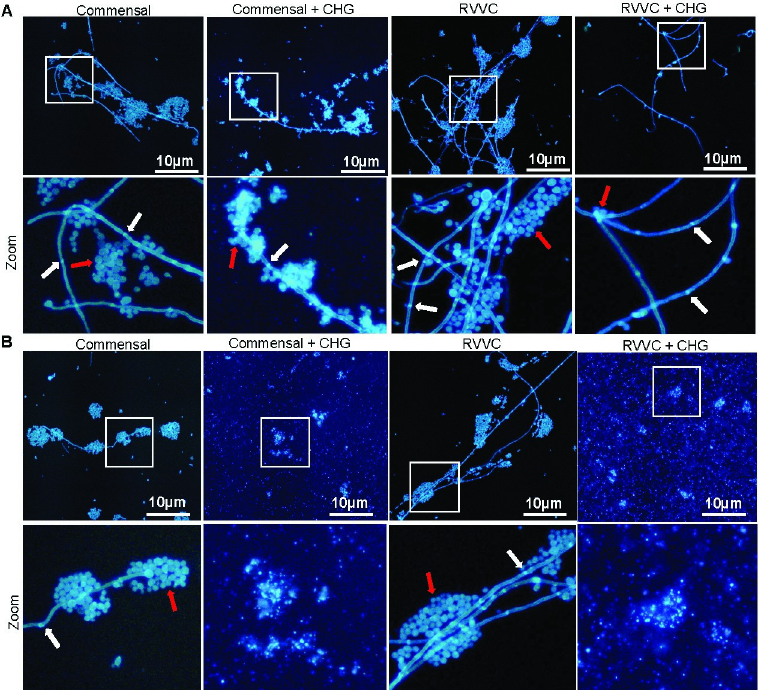
Fig 4. Chlorhexidine digluconate inhibits the hyphal growth of C . albicans . C . albicans obtained from patients with RVVC (n = 5) and from asymptomatic women, commensal strains (n = 5) were treated with chlorhexidine digluconate 0.02%. Imaging of hyphae from mature biofilm after 48h and another 24h with CHG treatment ( A). Newly formed biofilm was evaluated after 48h growth together with CHG (B). Staining was performed using blankophore p, images were captured using 20 × objective under UV in Olympus microscope. Representative images are shown. Marked areas were magnified, lower panel. Fungal septa are marked with white arrows and budding cells with red arrows.